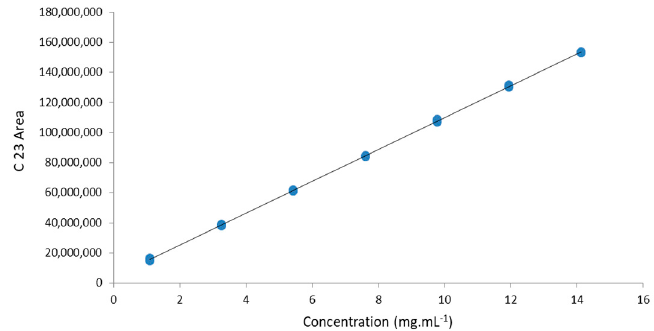
Figure 3. Analytical curve of the internal standard C23.